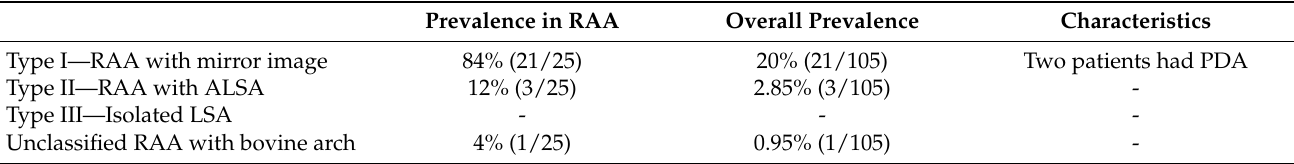
Table 4. Types of RAA according to the Edwards